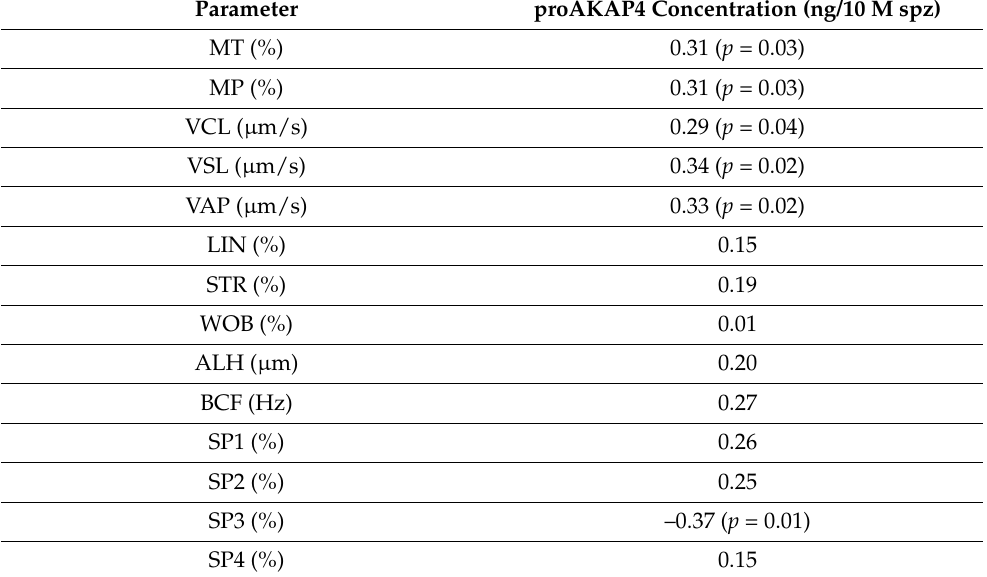
Table 2. Correlation coefficients between proAKAP4 concentration with sperm motility and motile sperm subpopulations of frozen–thawed horse ejaculates (n = 48).